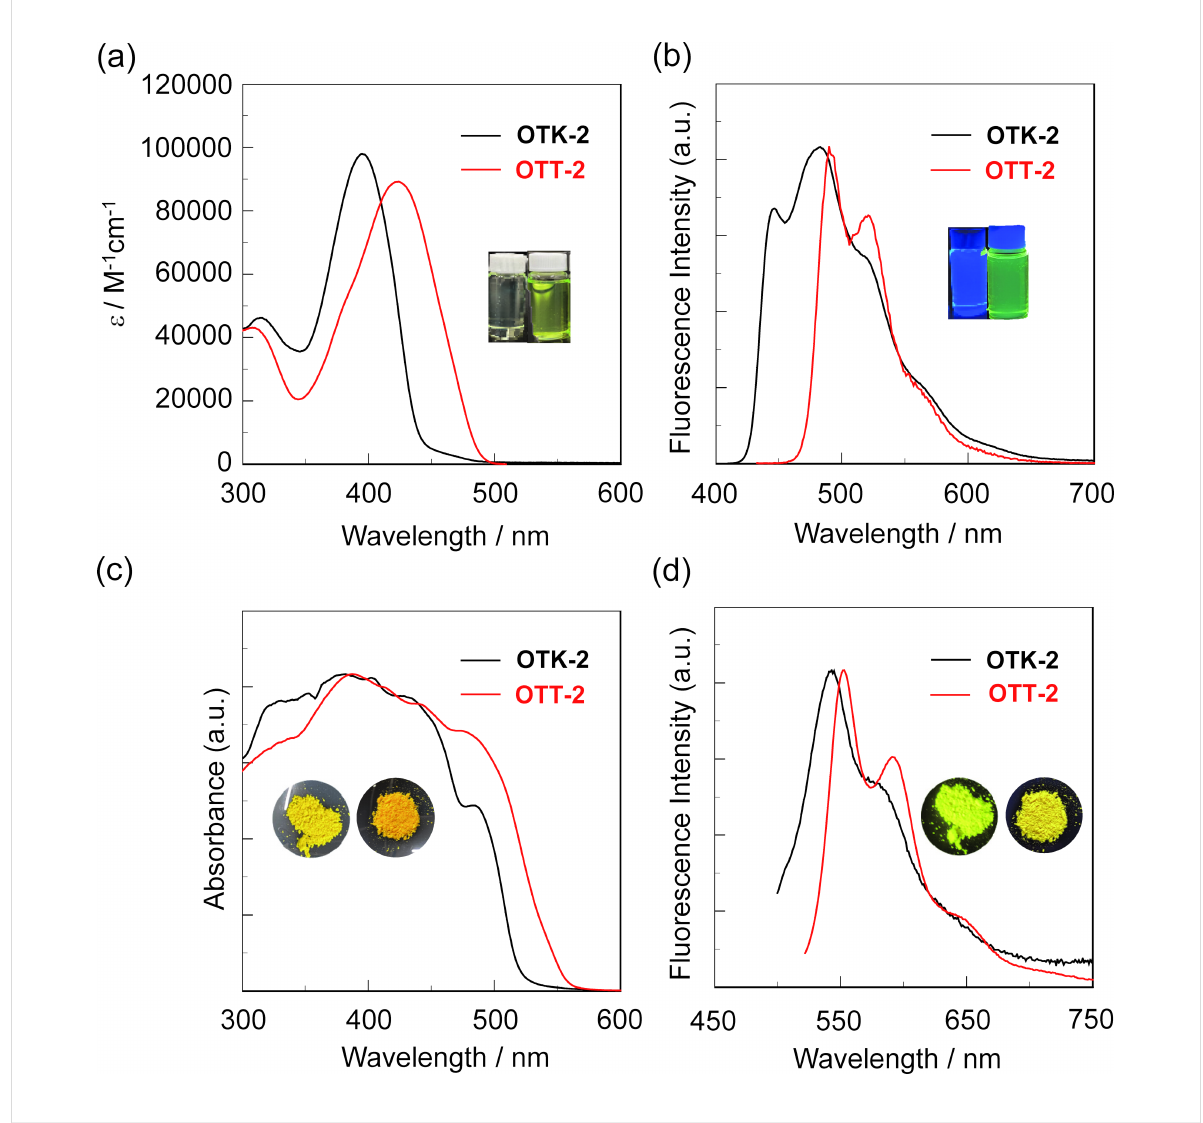
Figure 1: (a) Photoabsorption and (b) fluorescence ( λ ex = λ max,abs ) spectra of OTK-2 [33] and OTT-2 in toluene. (c) Solid-state UV–vis diffuse reflec- tion–absorption and (b) and (d) fluorescence spectra ( λ ex = 484 nm for OTK-2 [33] and 512 nm for OTT-2 ) of OTK-2 and OTT-2 in the solid state. Insets in (a) and (b): color and fluorescence images of OTK-2 (left) and OTT-2 (right) in toluene. Insets in (c) and (d): color and fluorescence images of OTK-2 (left) and OTT-2 (right) in the solid state. The photos depicted as insets in Figure 1a–d were reproduced from [33] (“Mechanofluo- rochromism of (D– π –) 2 A-type azine-based fluorescent dyes, © 2022 K. Takemura et al., published by the Royal Society of Chemistry, distributed under the terms of the Creative Commons Attribution 3.0 Unported License, https://creativecommons.org/licenses/by/3.0/).